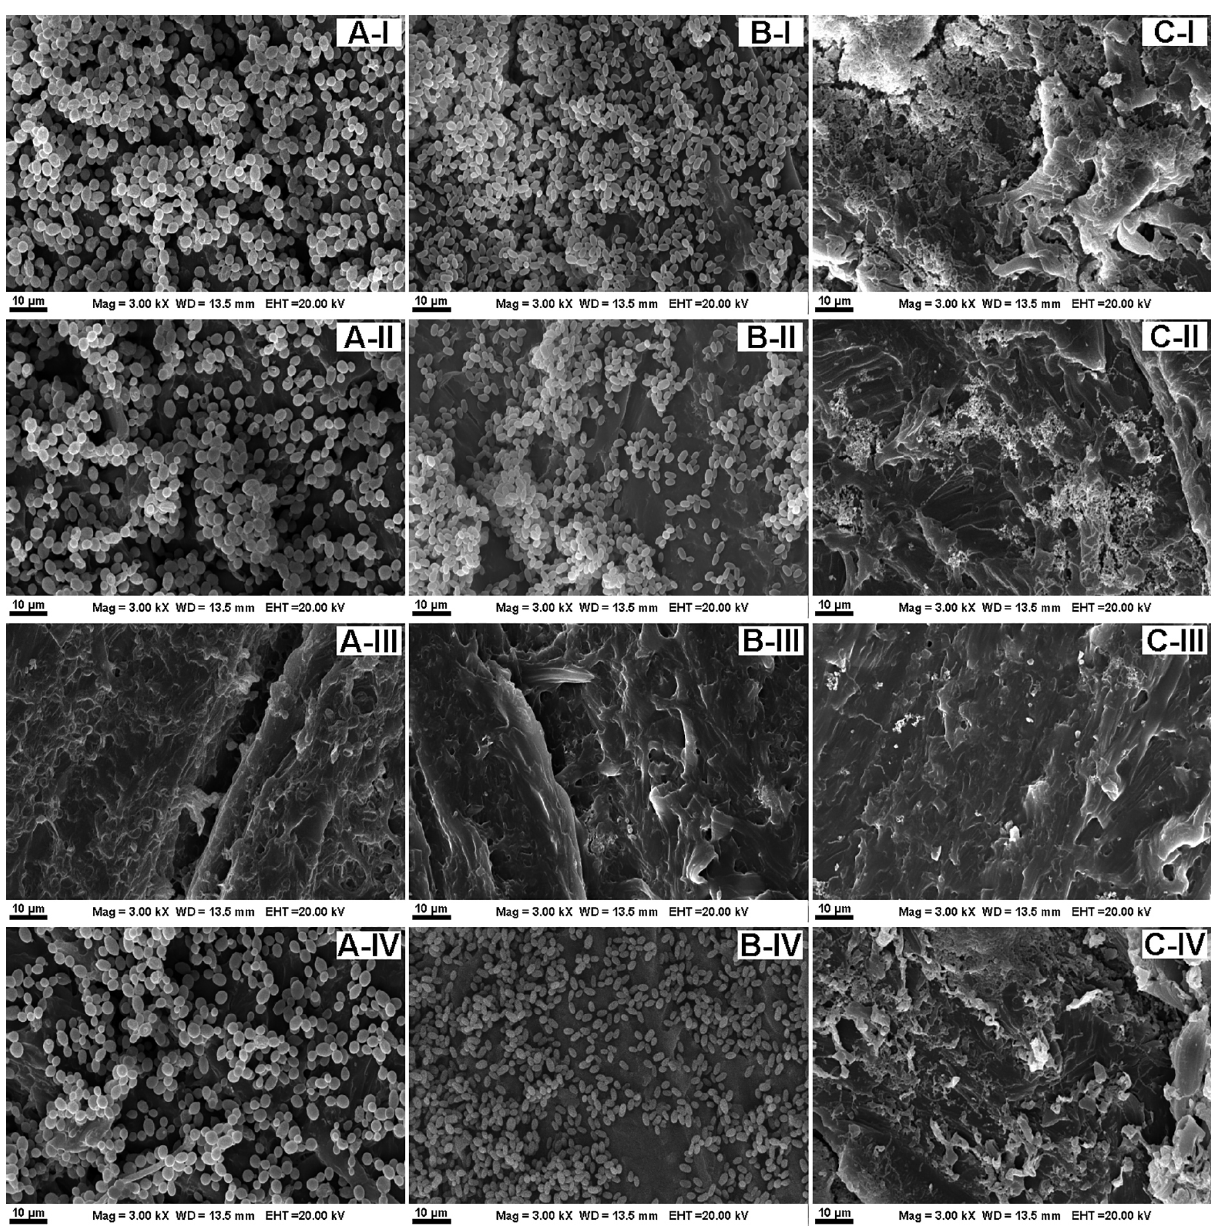
Figure 1- Representative scanning electron microscopy images after immersion in different hygiene solutions. A) C. albicans ; B) C. glabrata ; C) S. mutans . I) Control; II) RC – R. communis ; III) SH - Sodium Hypochlorite; IV) EPC – Efferdent Power Clean. Magnification 3000×. Scale bar = 10